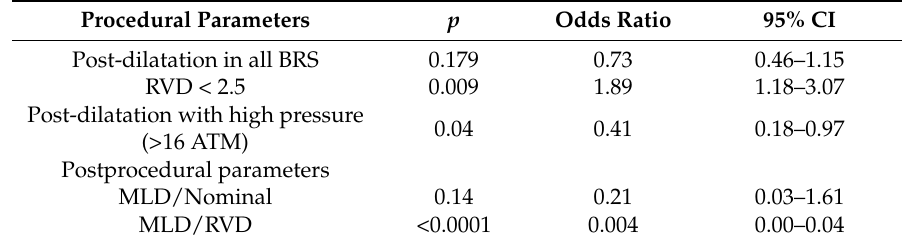
Table 2. Multivariate Cox regression analysis of the individual procedural and postprocedural characteristics with respect to TLF.